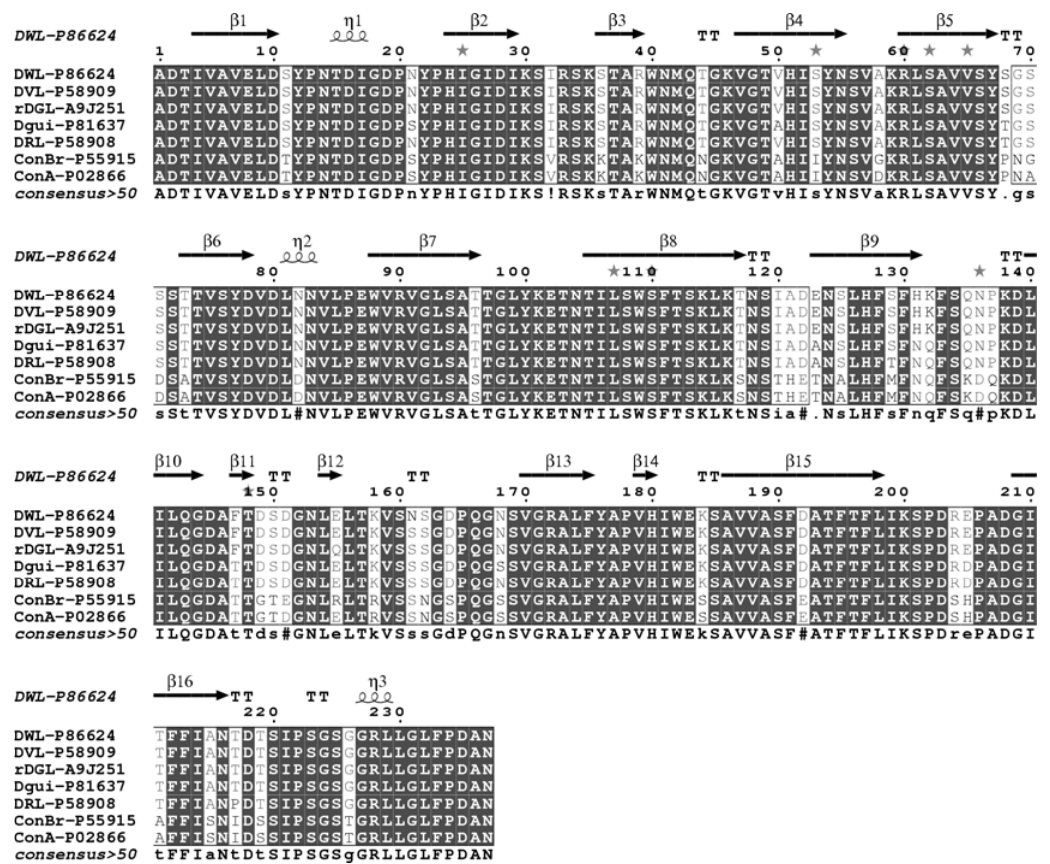
Figure 5. Primary sequence analysis. (a) Multiple alignment of rDGL, DVL, Dgui and DRL shows the highly conserved sequence in the secondary structure.